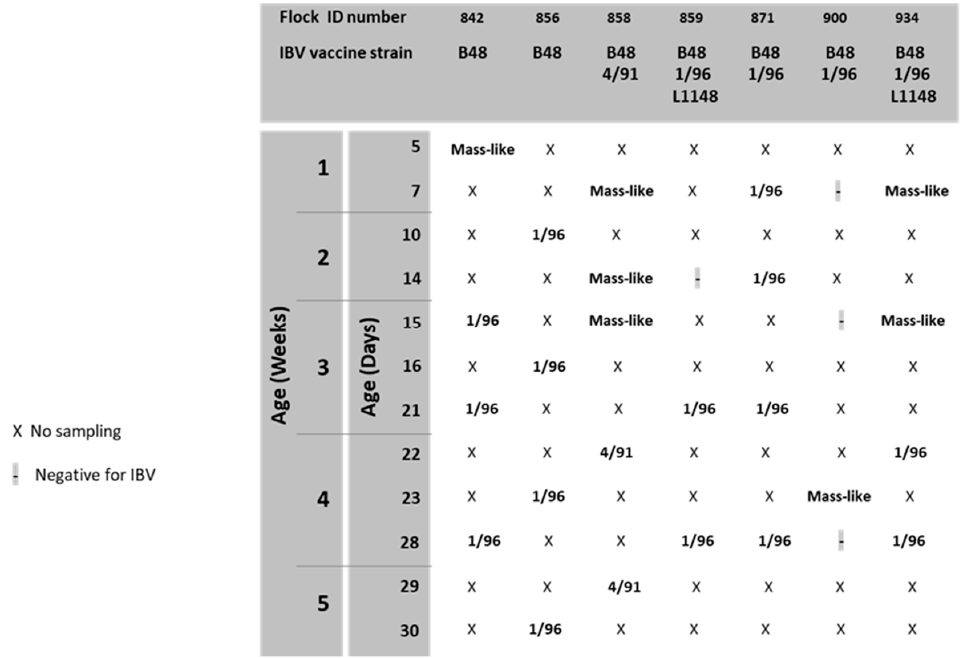
Figure 3 Results of IBV monitoring.